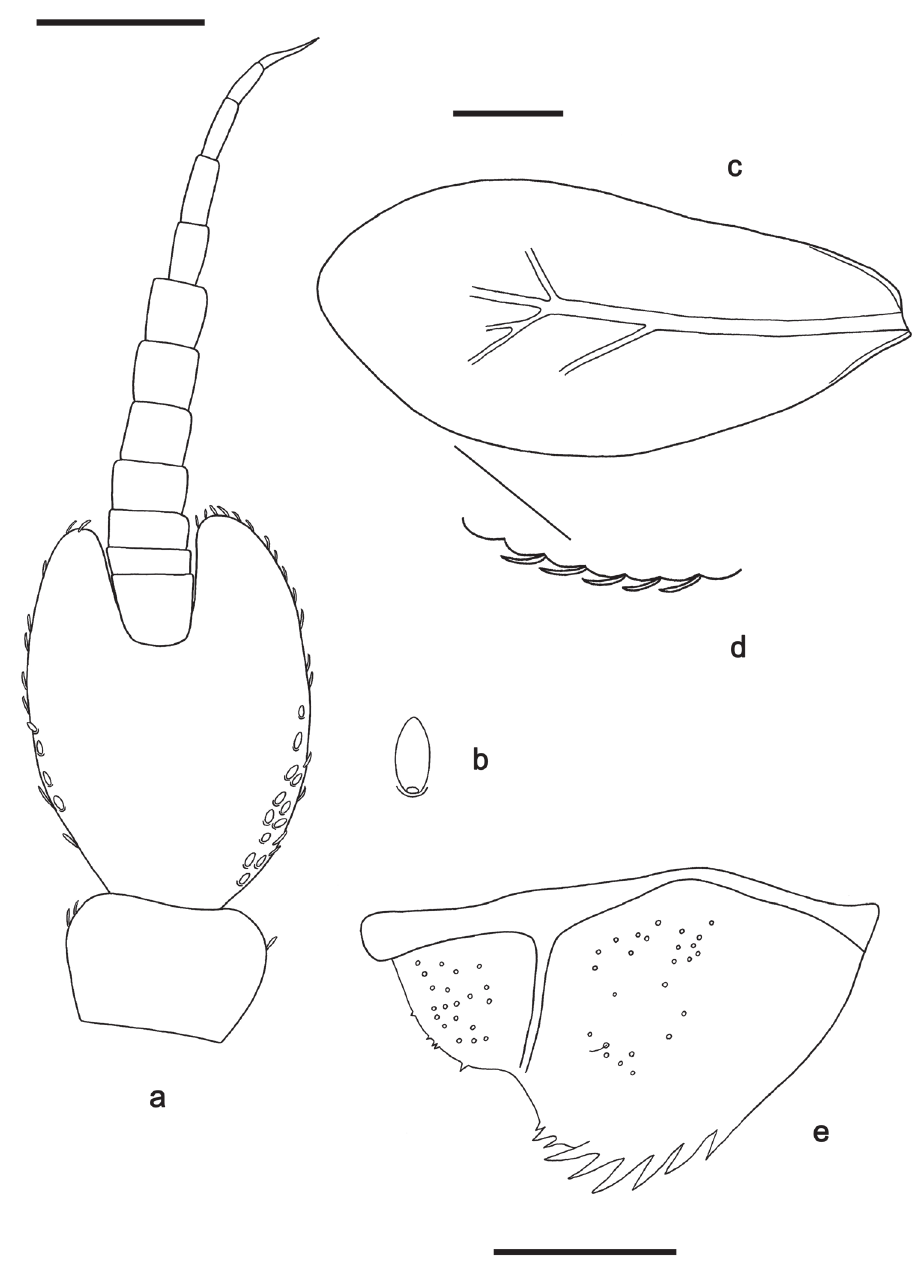
Figure 3. Pedicelliops capillifer gen. et sp. nov., larva morphology a antenna b scale of pedicellus c gill I d margin of gill I e paraproct. Scale bars: 0.1